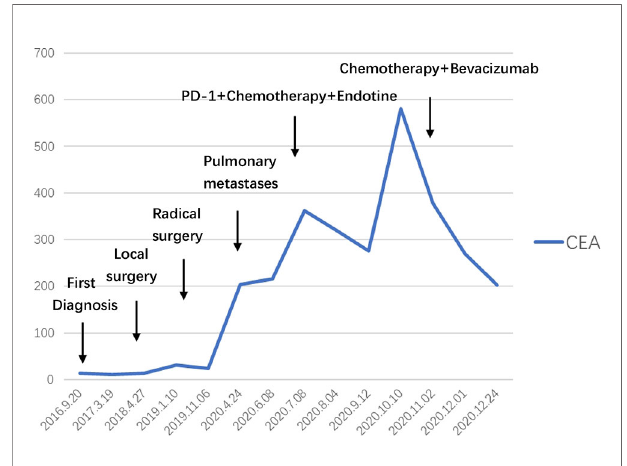
FIGURE 2 | Timeline of the Serum